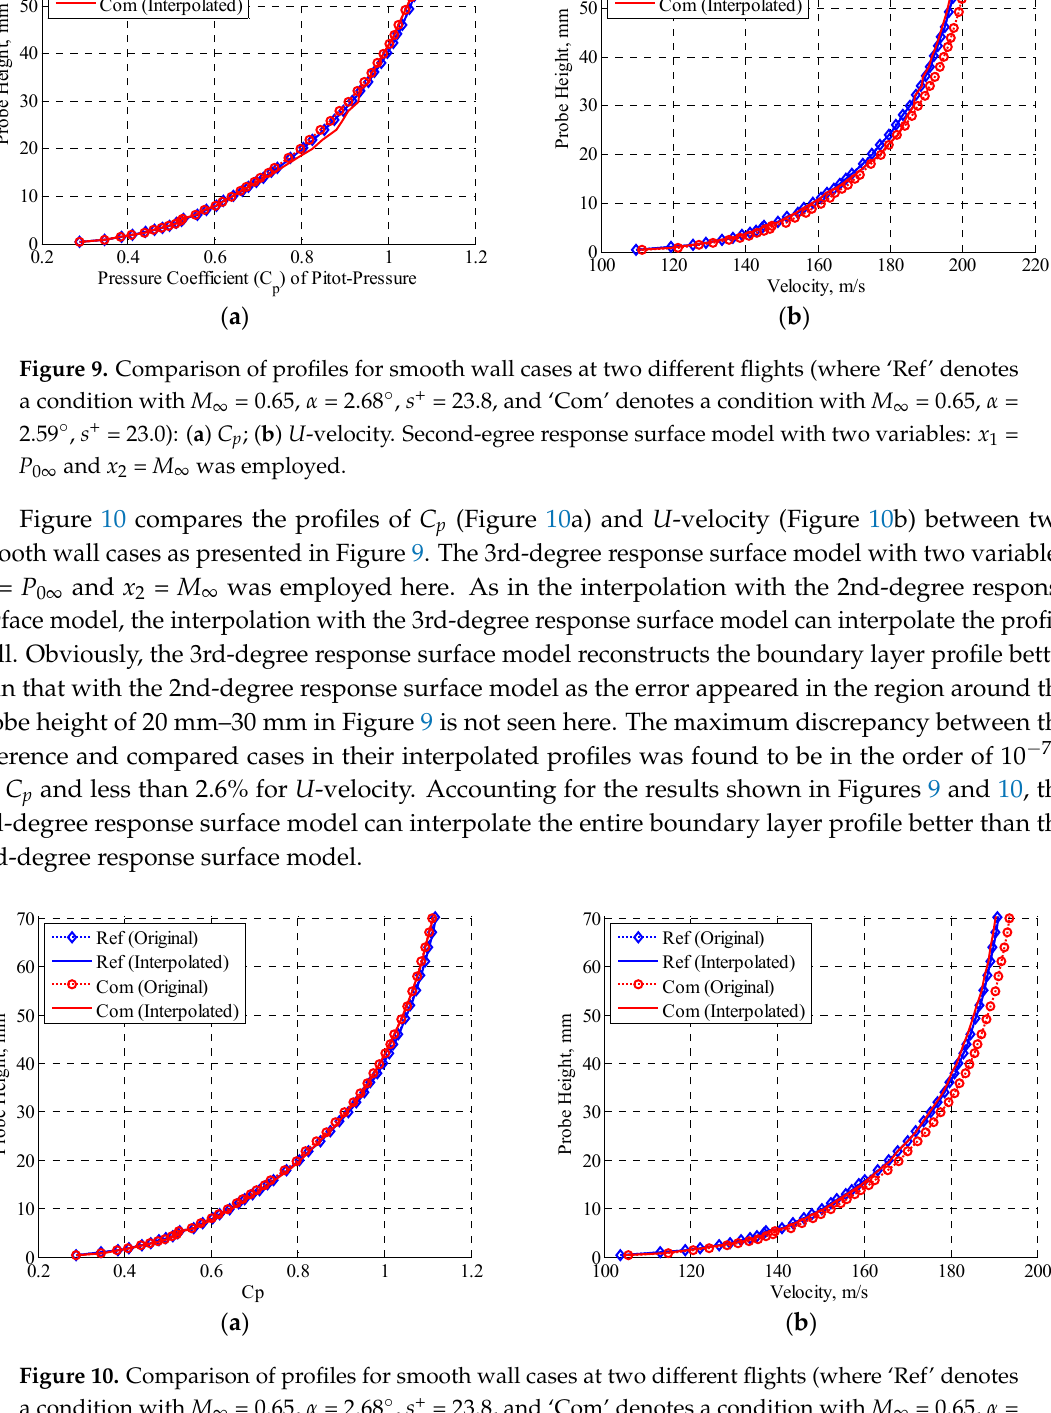
2.59°, s + = 23.0): ( a ) C p ; ( b ) U -velocity. Third-degree response surface model with two variables: x 1 =